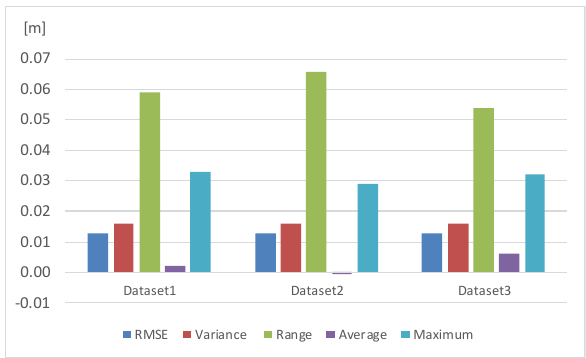
Figure 5. Results of the evaluation at 75